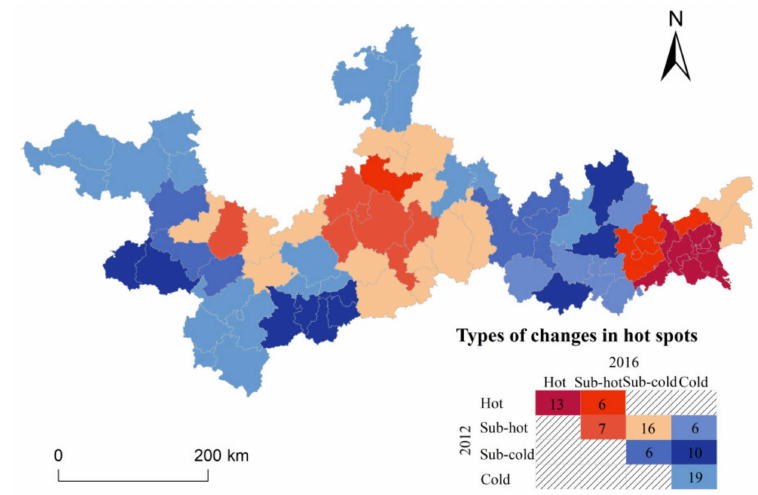
Figure 5. Types of changes in hot spots in the